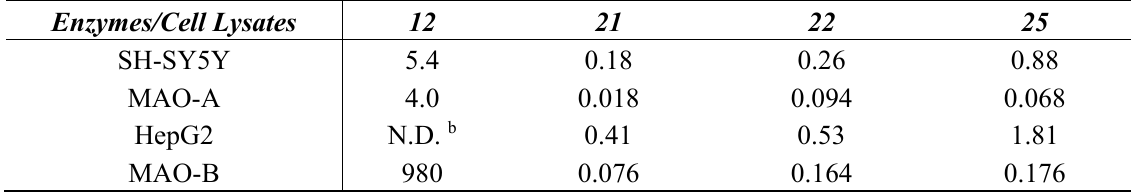
Table 2. MAO inhibitory activity ( μ M) in different cell lysates a